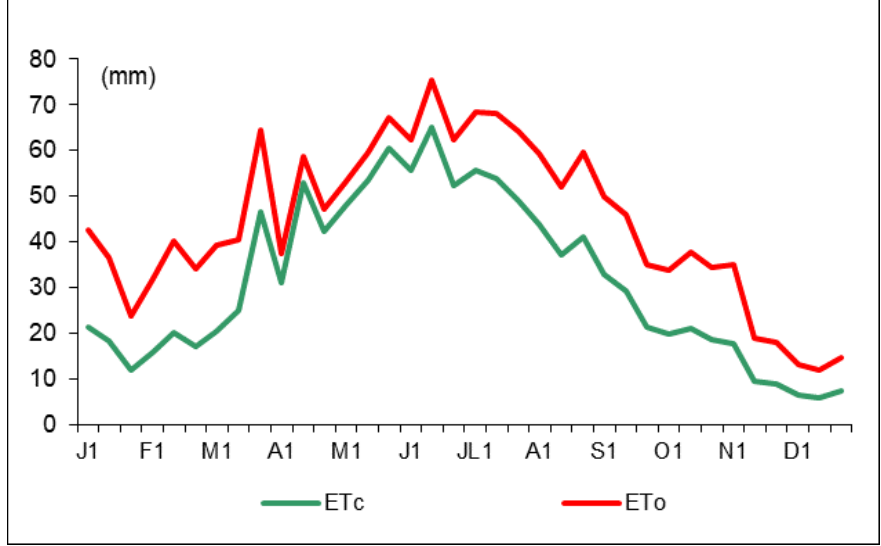
Figure 2. Ten-day reference evapotranspiration (ET 0 , red line) and crop evapotranspiration (ETc, green line) values during 2016.